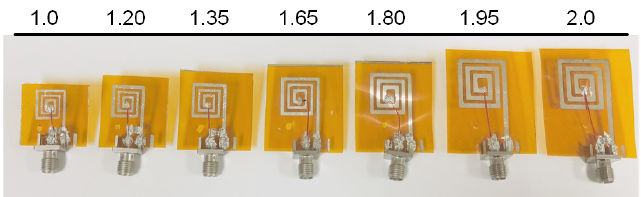
Figure 4. Fabricated scaled flexible coil prototypes.